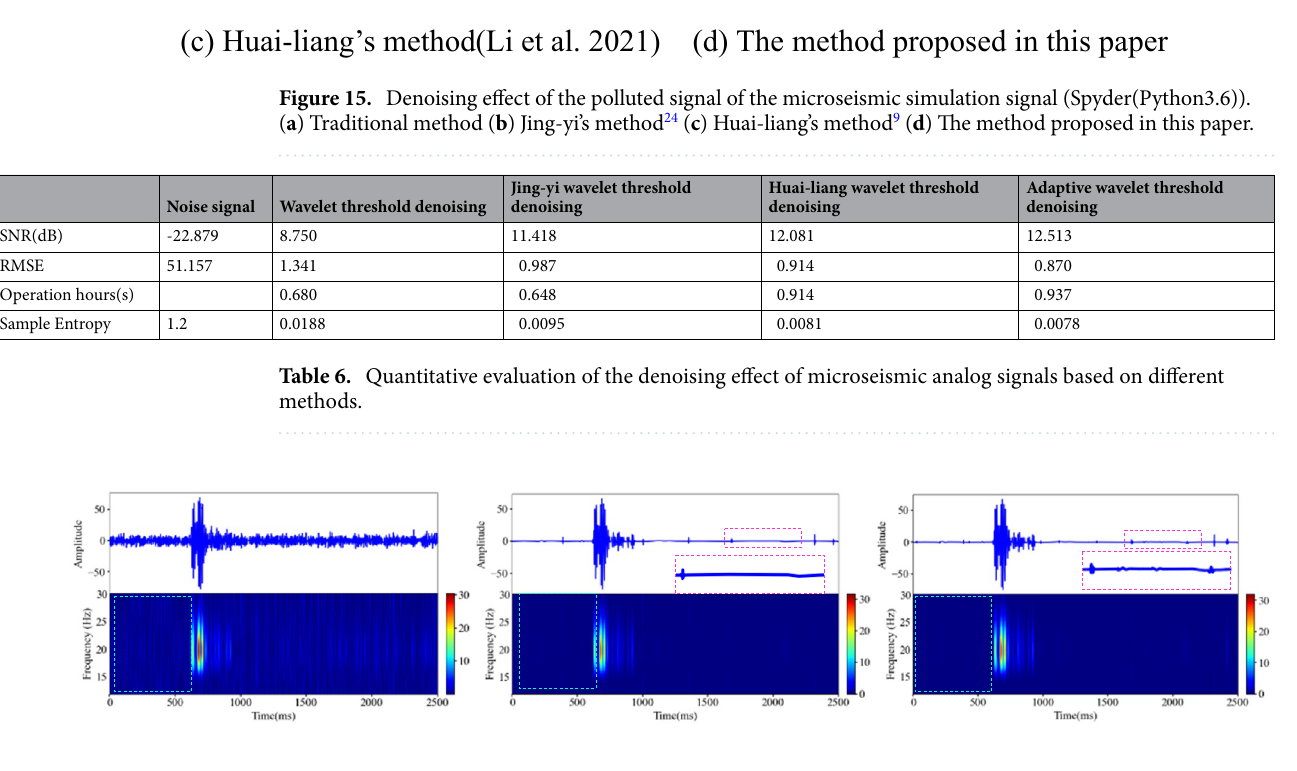
Figure 16. Denoising processing of rockburst monitoring signal (Spyder(Python3.6)). ( a ) Raw monitoring data ( b ) The method proposed in this paper ( c ) Huai-liang’s